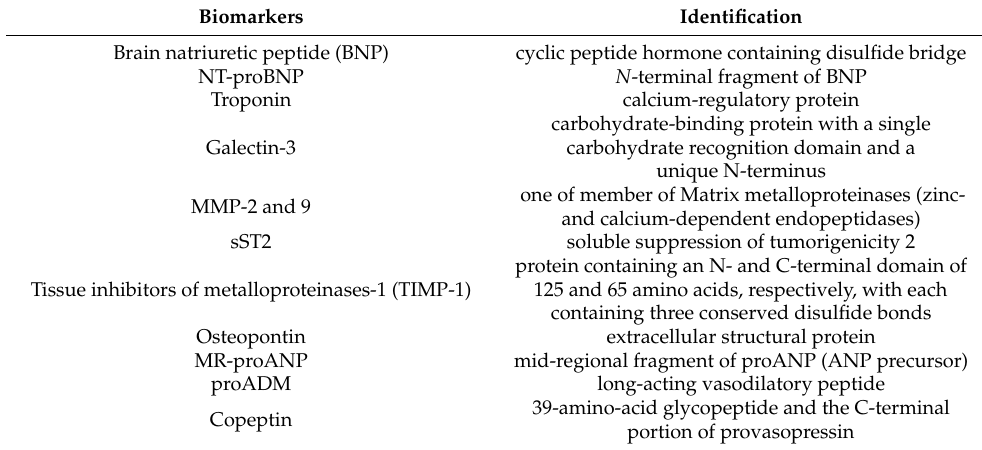
Table 1. Identification of heart failure-related biomarkers for patients undergoing